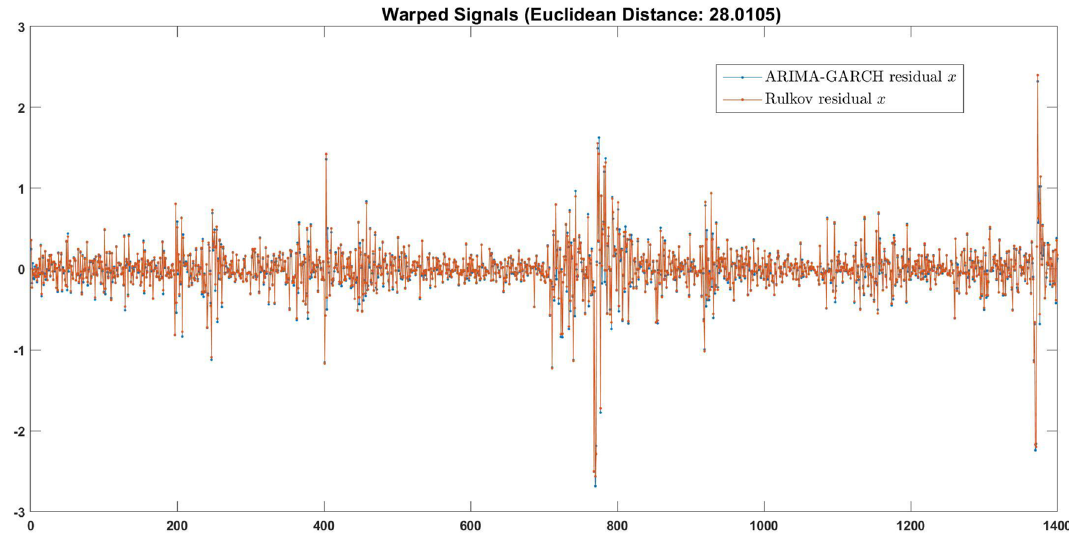
Figure 6. Rulkov map and ARIMA-GARCH ∗ residuals almost